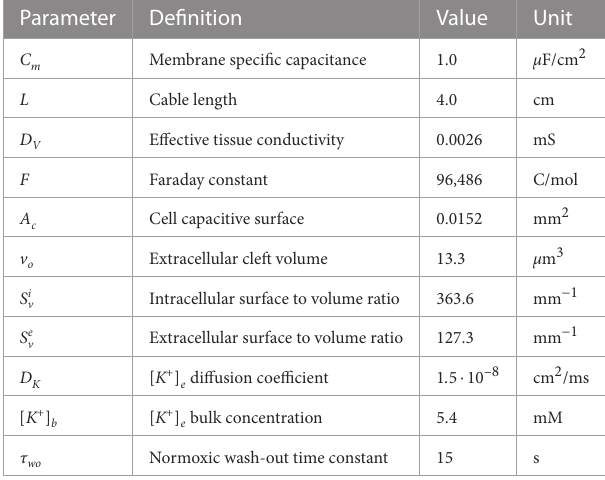
TABLE1 Modelparametersfortheelectrophysiologyandtransport